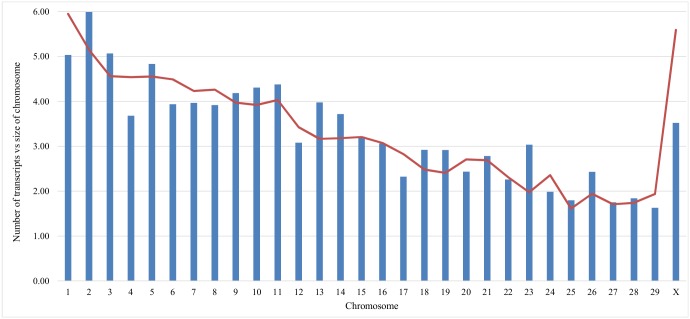
Total number of class 3 putative lncRNA per chromosome vs the size of each chromosome. This figure shows the correlation with the number of class 3 putative lncRNA found on each chromosome vs the actual size of our chromosome. The blue bars indicate the number of class 3 transcripts (as a percentage of the total number). The red line indicates the size of the chromosome (as a percentage of the total nucleotide size).